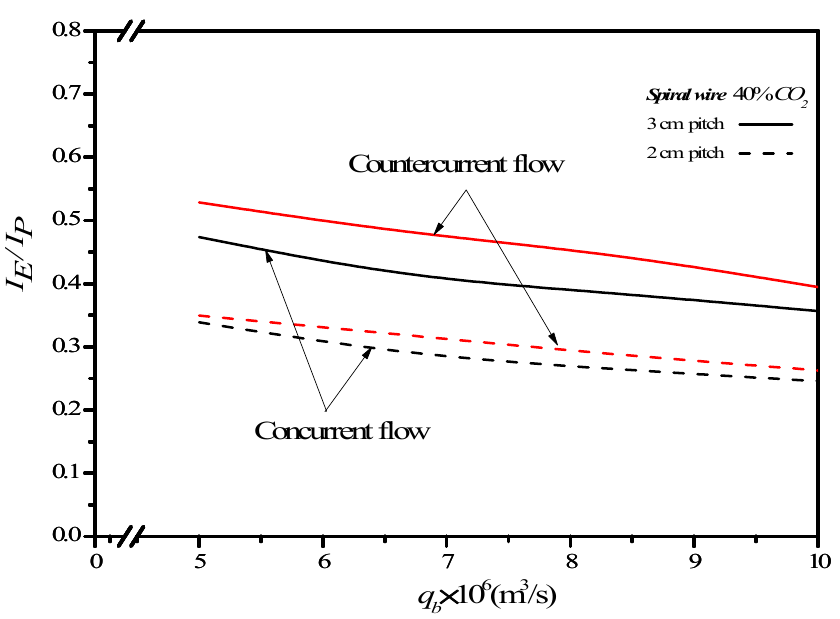
Figure 12. Effects of MEA feed flow rate and spiral-wire pitch on PE II / .